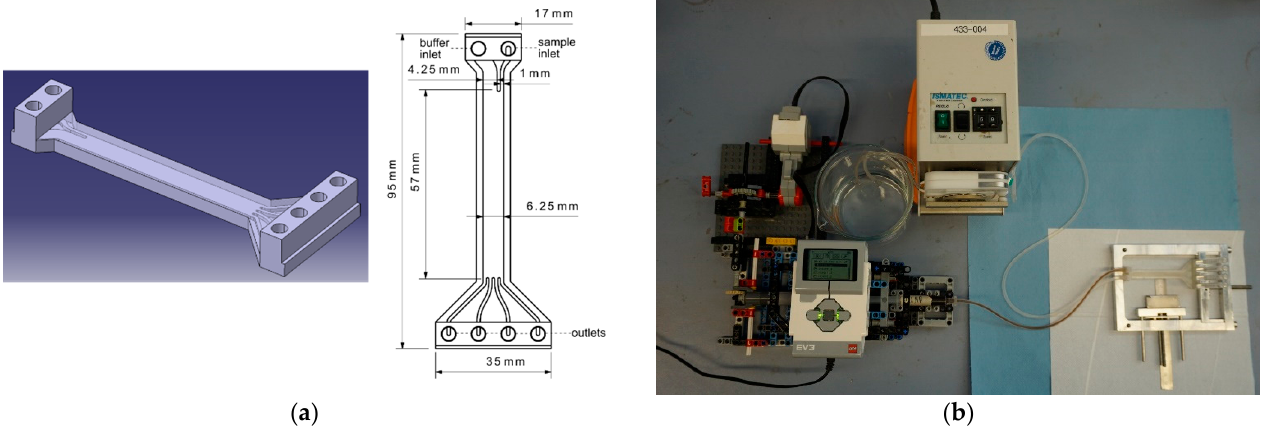
Figure 9. ( a ) Three ‐ dimensional model and top view of the printed millifluidic chip. The sorting device features two inlets, one for the buffer and one for the samples to be sorted. During the passage, the particles are deflected into four different outlets. ( b ) Complete setup of the yeast sorting apparatus.